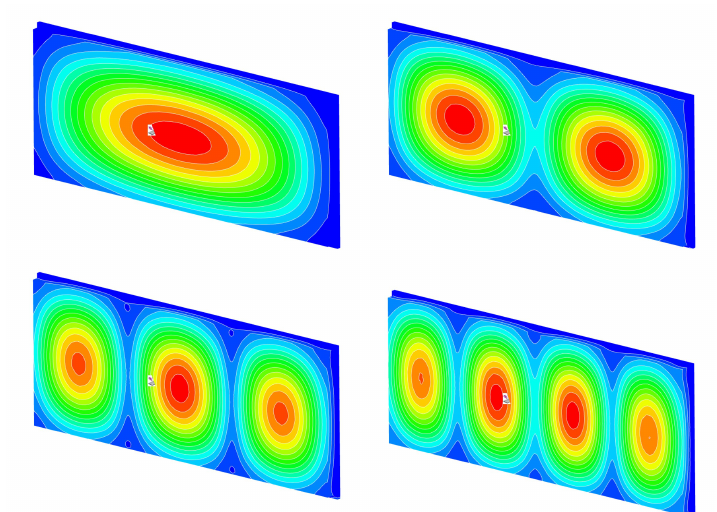
Figure 9. Window vibration velocities at sensors as functions of frequency.